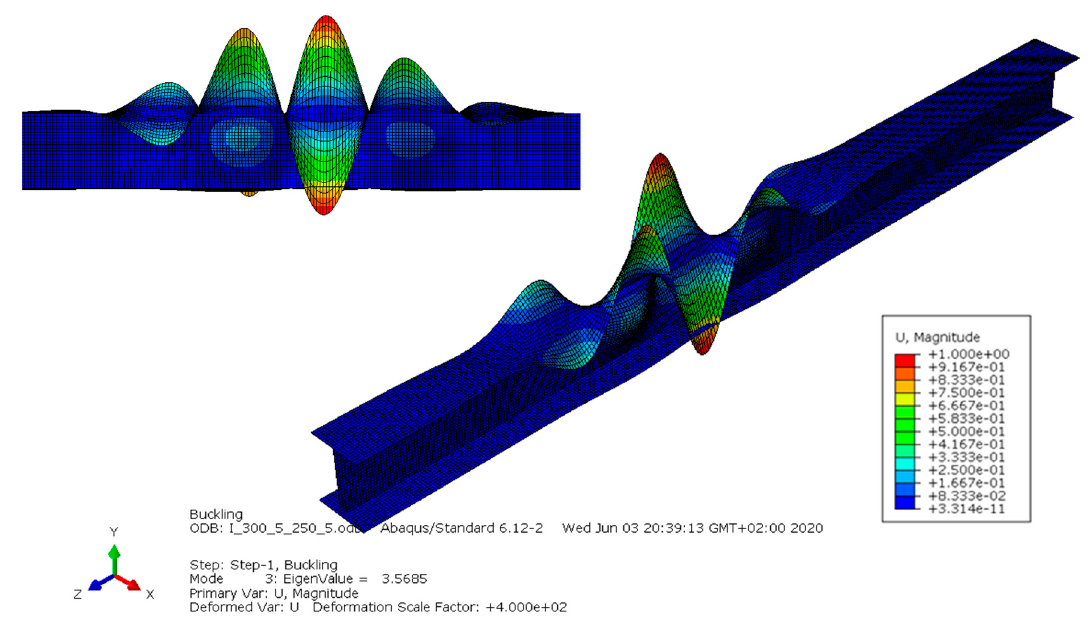
Figure 8. Local buckling of I-300 × 5 × 250 × 5 beams in the span zone.